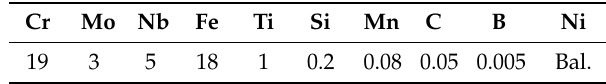
Table 1. Chemical composition (wt. %) of the MetcoClad 718 [24]. Cr Mo